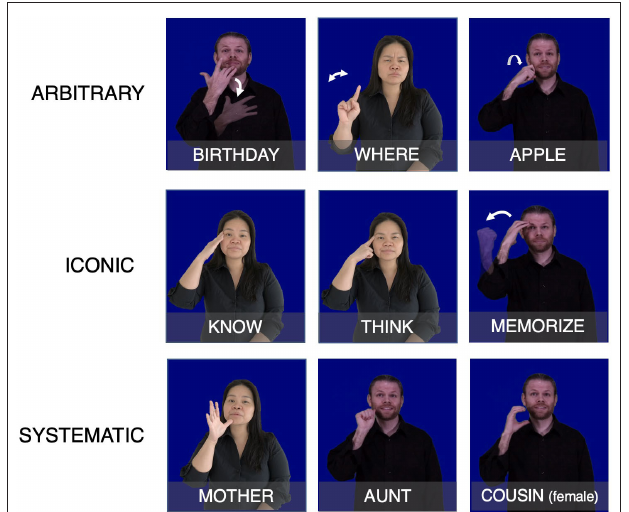
FIGURE 1 | Examples of arbitrary (top row) , iconic (middle row) , and systematic (bottom row) signs in ASL. The verbs of cognition in the middle row are all articulated on the head, which indicates their relationship to the brain through iconicity. The kinship signs in the bottom row are all articulated near the chin, which is conventionally associated with feminine roles among ASL kinship